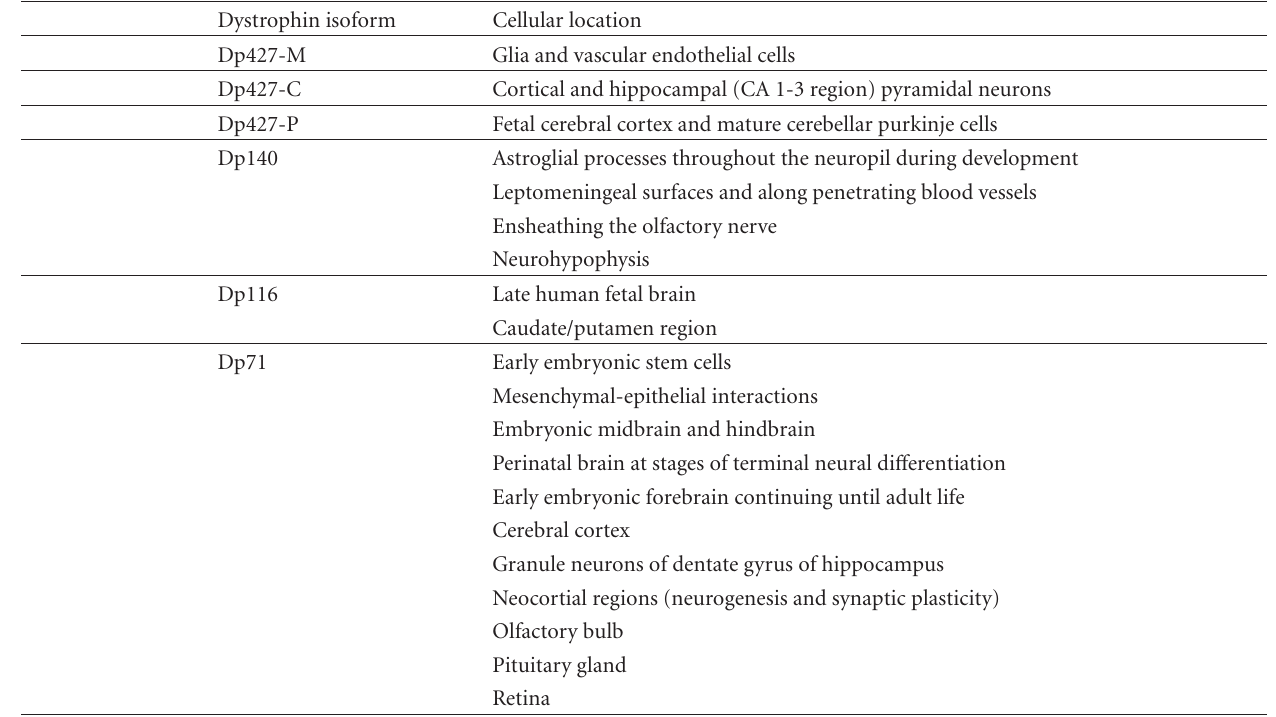
Table 1. Location of the brain isoforms of dystrophin throughout the